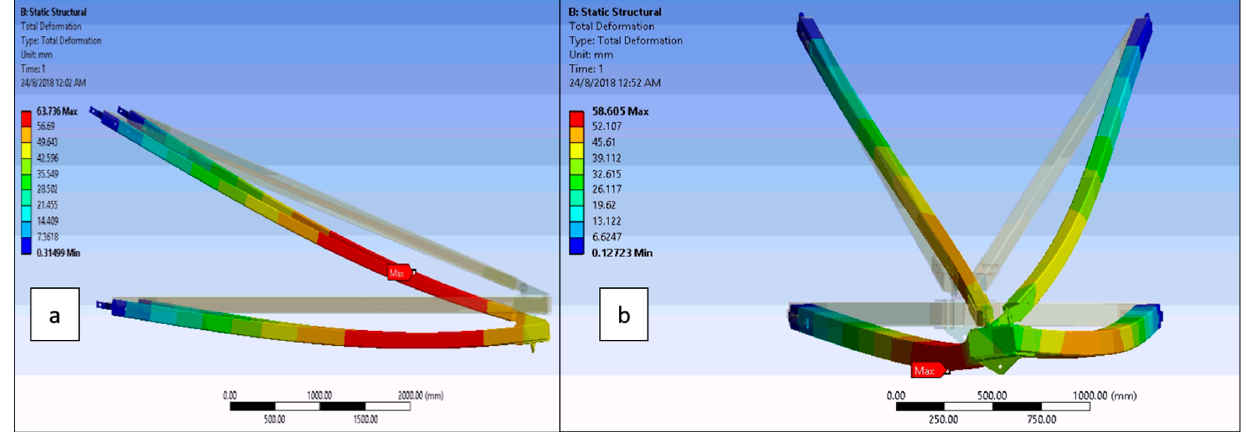
Figure 5. Schematic diagram of cross-arm structure when exposed applied force at the end of the cross-arm structure ( a ) side view and ( b ) front view [127].